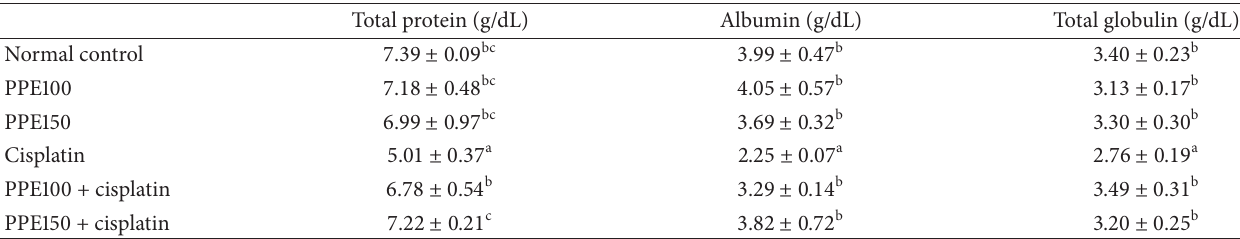
Table 4: Effect of Physalis peruviana L. extract on serum protein metabolism parameters in normal and cisplatin induced ARI rats. Total protein